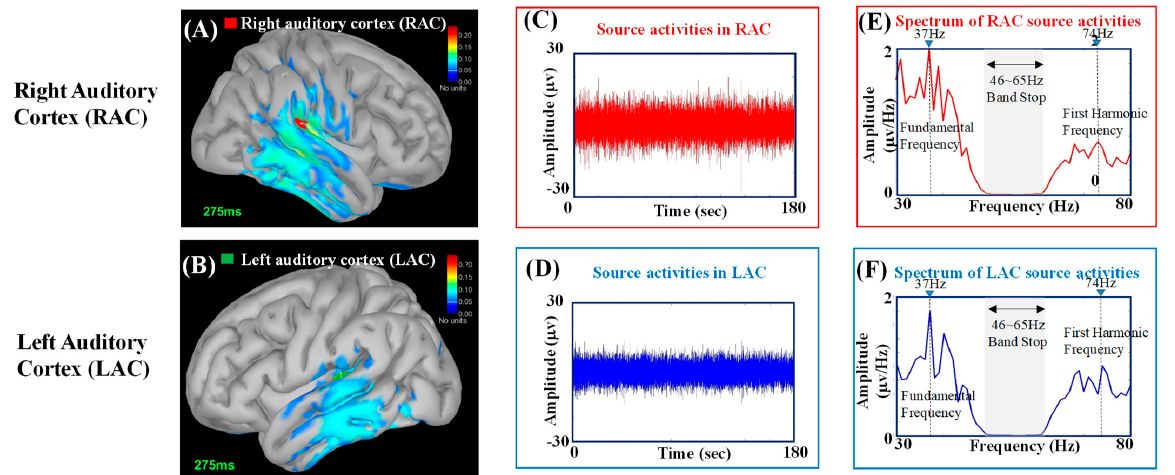
Figure 2. The source activities of ASSRs estimated by MNE in RAC and LAC: ( A ) The neural sources of ASSR in RAC; ( B ) the neural sources of ASSR in LAC; ( C ) the source activities in RAC; ( D ) the source activities in LAC; ( E ) the Fourier spectrum of the source activities in RAC; ( F ) the Fourier spectrum of the source activities in LAC.